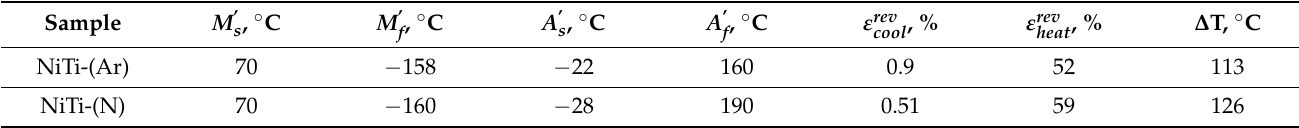
Table 4. SME parameters of porous NiTi-(Ar) and NiTi-(N)